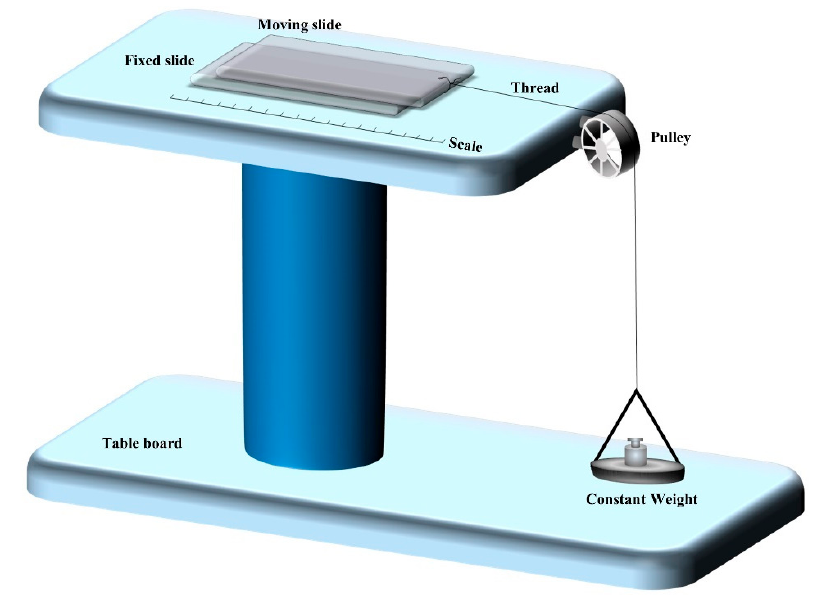
Figure 2 . Spreadability test using the wooden block method. Figure 2. Spreadability test using the wooden block